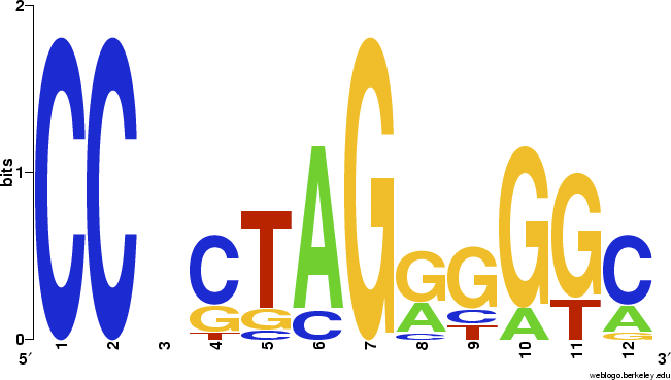
Vertebrate CTCF ConsensusShown is the sequence logo of a CTCF consensus sequence derived from sites collated in Moon et al. [13]. Both the vertebrate and the Drosophila motifs share the AGGNGGC consensus sequence, and the strong CC at positions1,2 in the vertebrate motif corresponds to the weaker CC preference at positions 4,5 in the Drosophila motif.